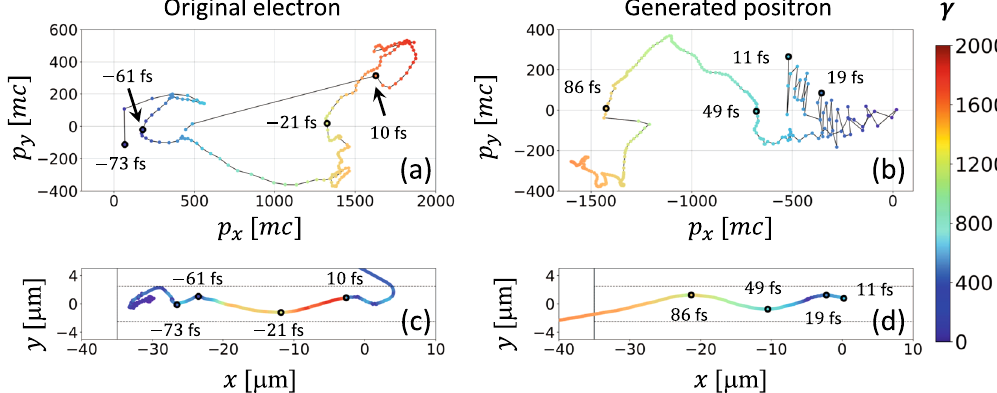
Fig. 2 Trajectories of an accelerated plasma electron and a generated positron. Trajectories of an accelerated plasma electron and a generated positron from the 2D PIC simulation shown in Fig. 1: a , b tranverse momenta p x , p y and c , d position in the x - y plane. Color coding denotes the magnitude of the relativistic factor γ . The vertical solid line is the initial position of the left edge of the target. The horizontal dashed lines show the initial location of the channel walls. The timestep between the colored markers is 0.5 fs. Timestamps are provided for selected markers (shown as dark circles) to facilitate comparison between trajectories in ( p x , p y )-space and ( x , y )-space. To improve visibility, the electron trajectory in ( a ) is shown for − 73 fs ≤ t ≤ 11